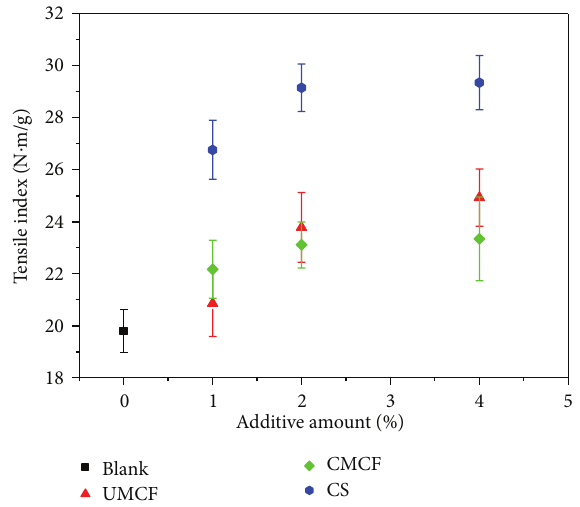
Figure 7: The tensile index of paper sheets with various additive amounts of three additives (UMCF, CMCF, and CS).